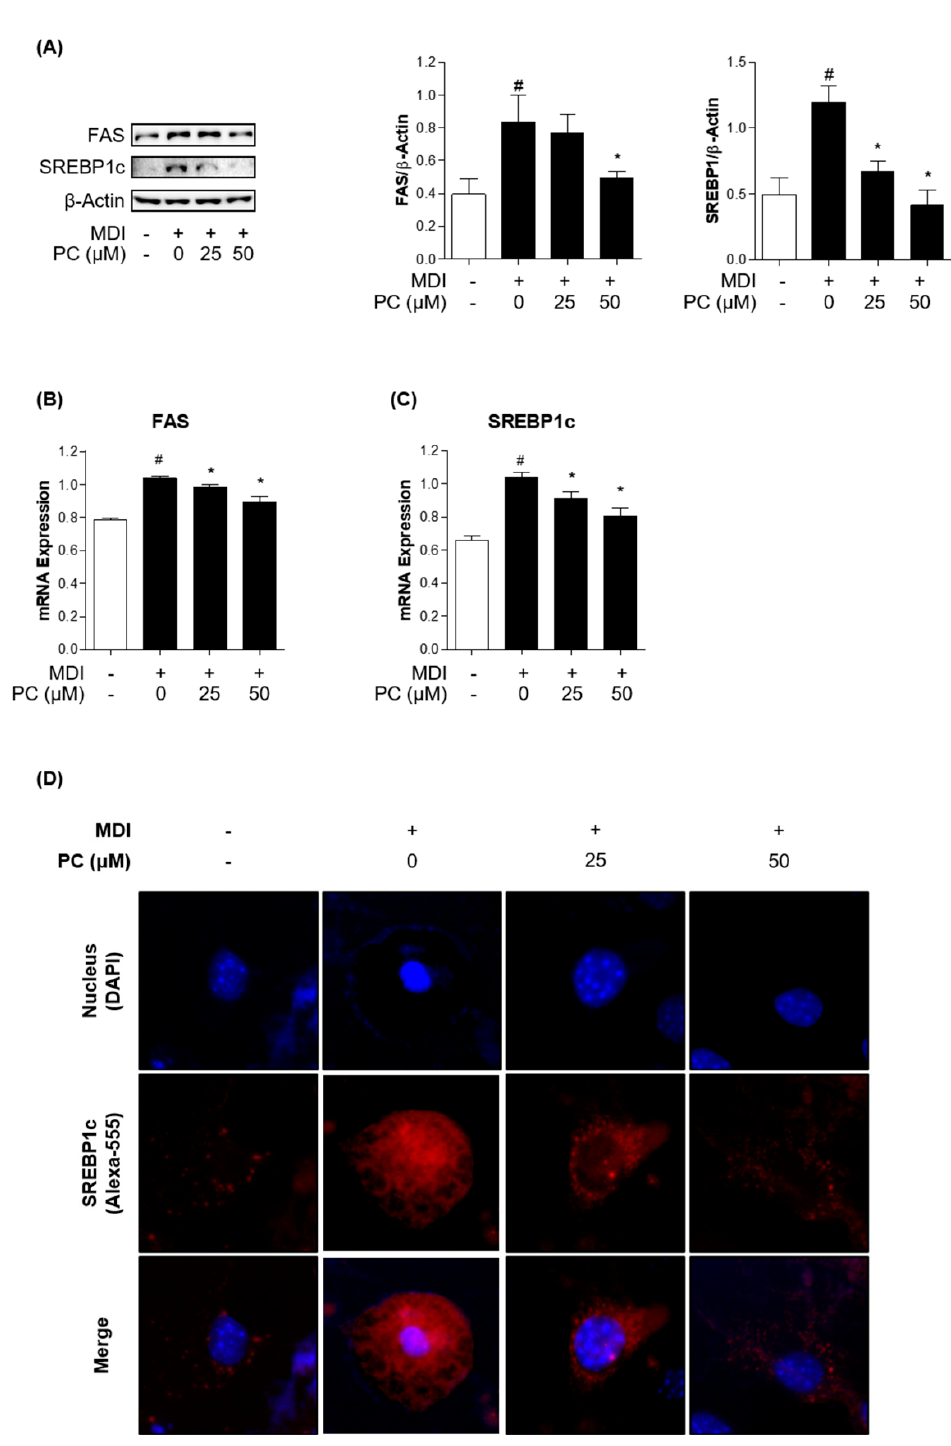
Figure 3. Effect of PC on lipogenic factor expression levels: The protein levels of FAS and SREBP1c were detected by Western blotting ( A ), and mRNA levels were detected by real-time PCR ( B , C ); ( D ) SREBP1c in differentiated 3T3-L1 adipocytes was detected by immunofluorescence analysis using microscopy (magnification: 400 × ). The experimental data were obtained from at least three independent experiments and shown as means ± standard errors of the means. # p < 0.05 compared to the control (non-treated) group. * p < 0.05 compared to the MDI-treated group.